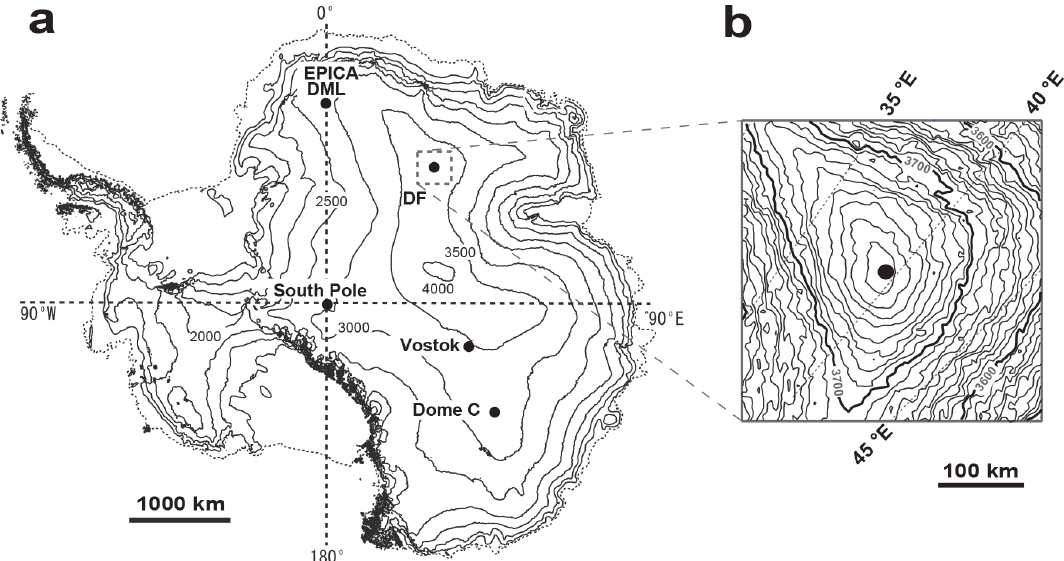
Figure 1. Maps of (a) the whole of Antarctica and (b) the area around Dome Fuji. Surface elevation values (in m) are based on the digital elevation model of Bamber et al. (2009).